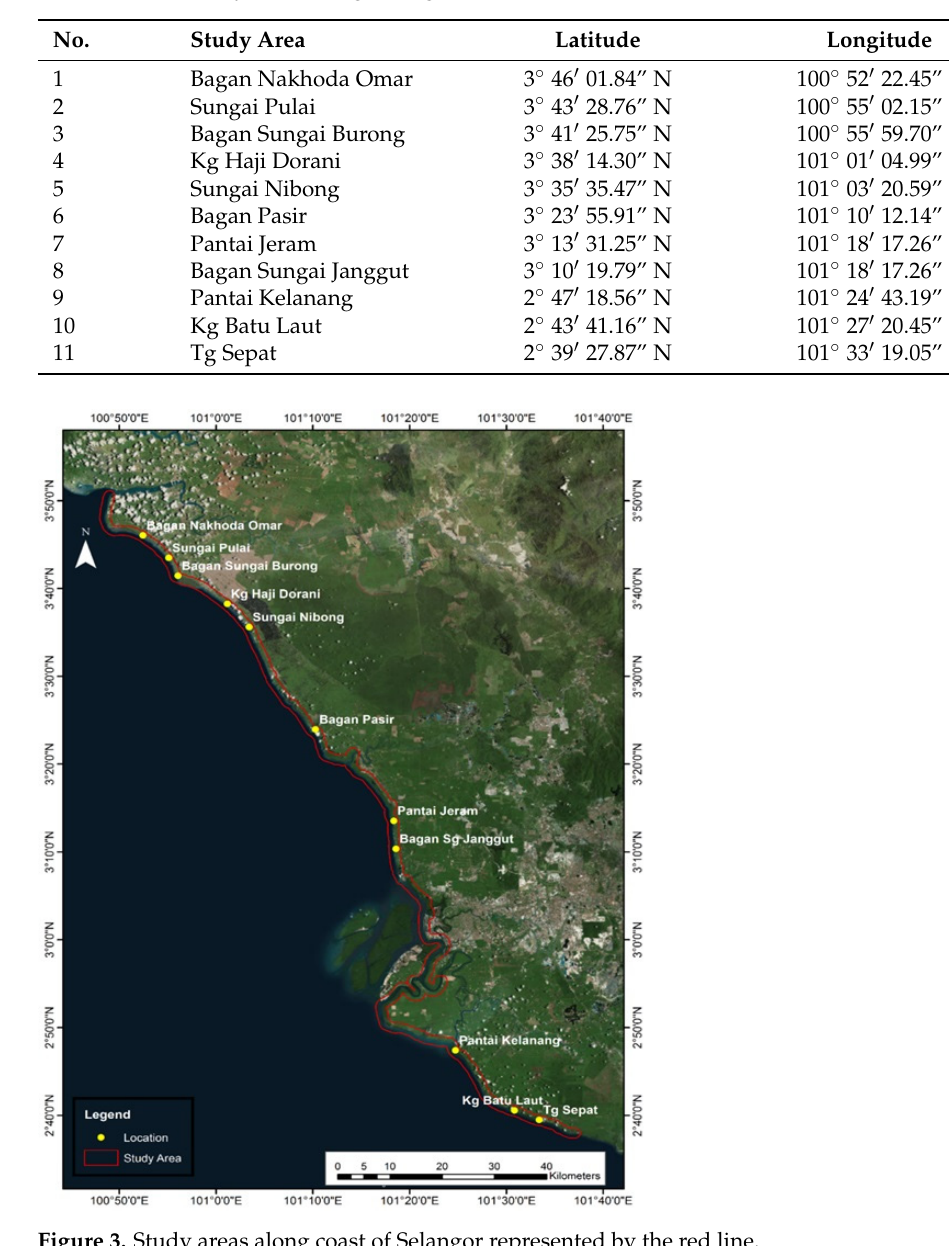
Table 1. List of study areas along Selangor coast.